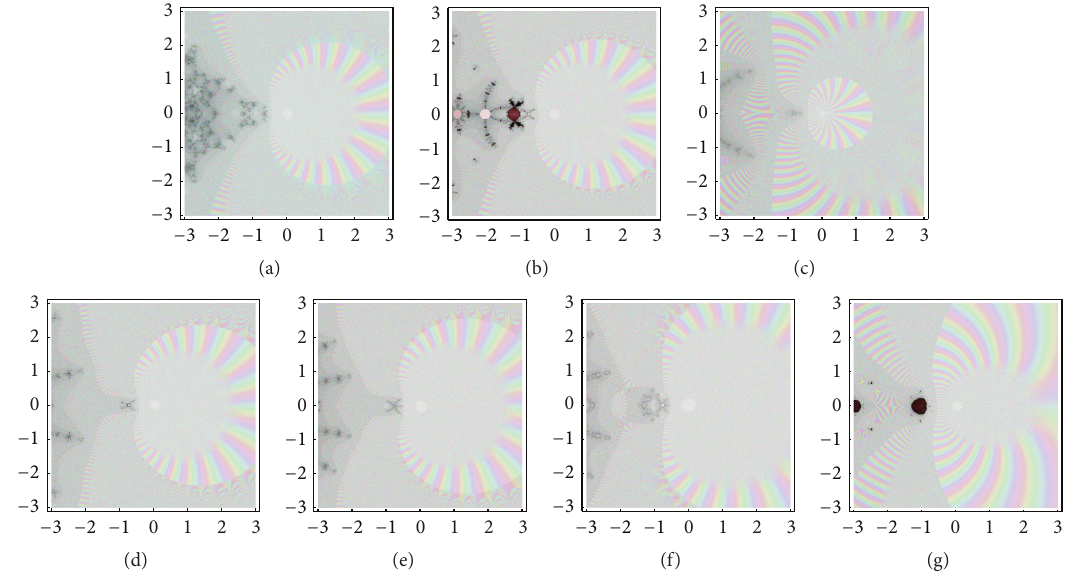
Figure 2: (a) for Kan , (b) for Sol , and (c) for Zhou and (d) for 1D , (e) for 1G , (f) for 2D , and (g) for 2G , for the roots of the polynomial (𝑧) = 𝑧 3 (𝑧 + 1) . 𝑃 2